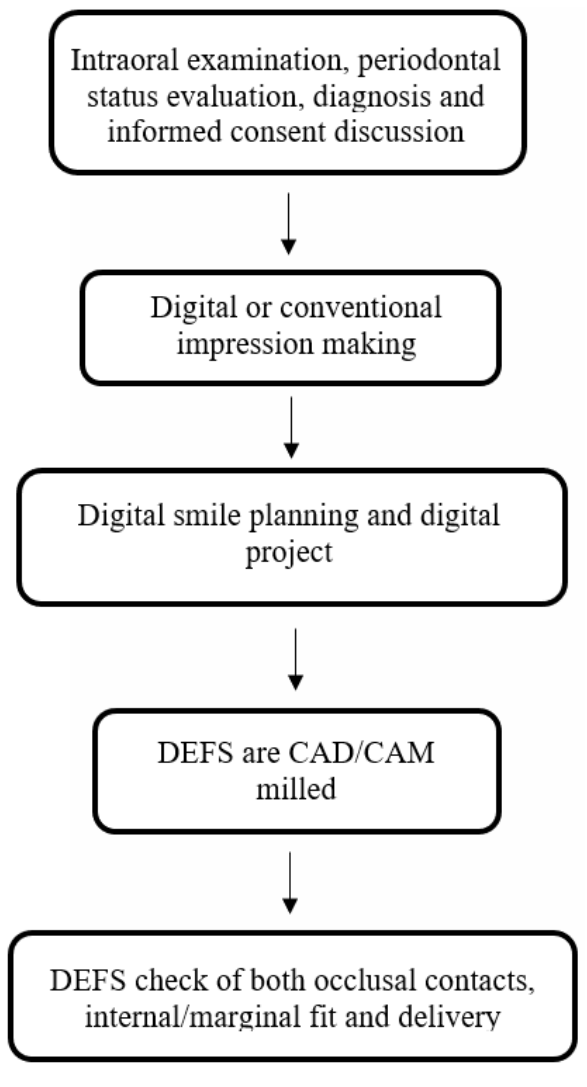
Figure 19. DEFS workflow.